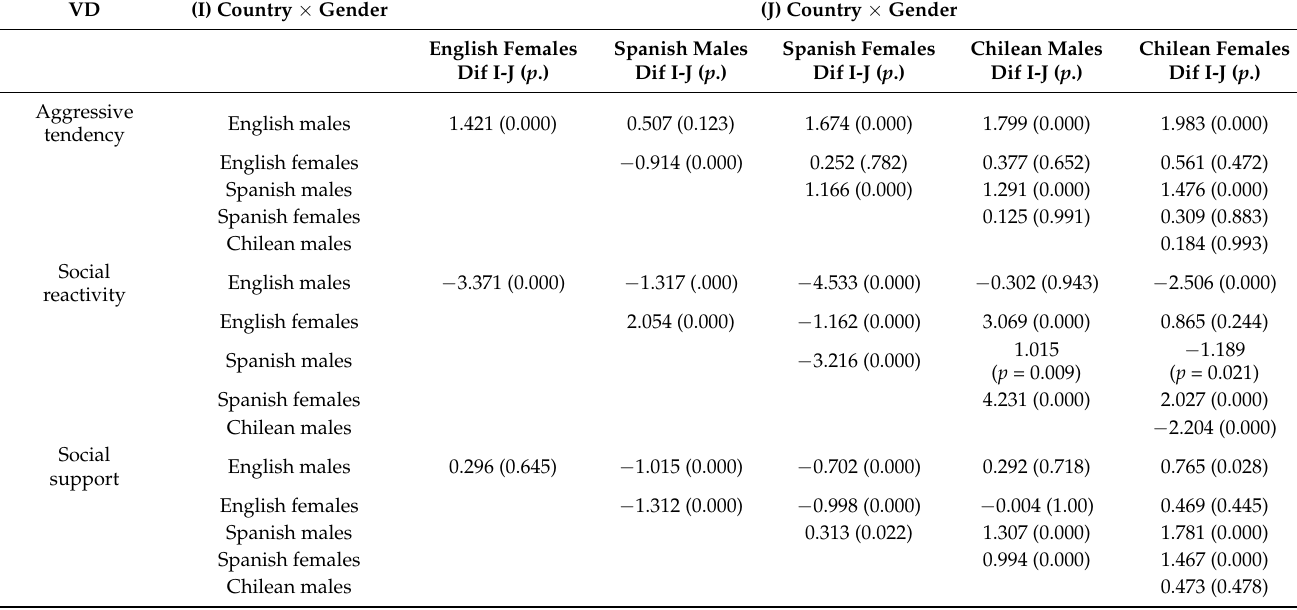
Table 6. Post hoc test of differences according to the variable country ×